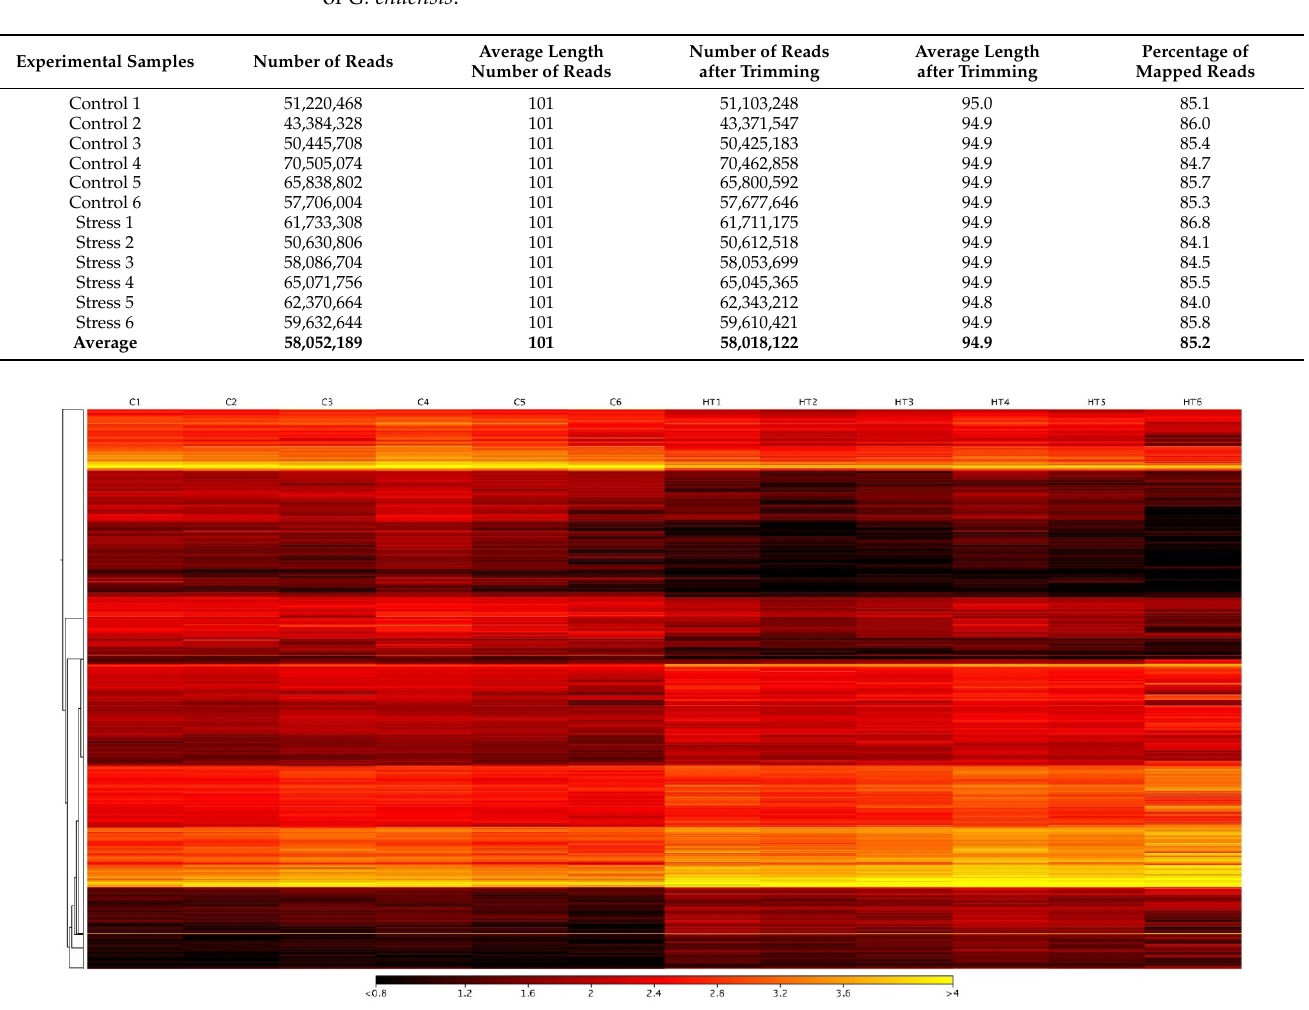
Figure 3. Differentially expressed transcripts in response to high-temperature stress in G. chilensis. The heatmap presents the differentially expressed transcripts between control (C) and stress groups (HT). The numbers 1 to 6 indicate the sample library of control and stress fish.